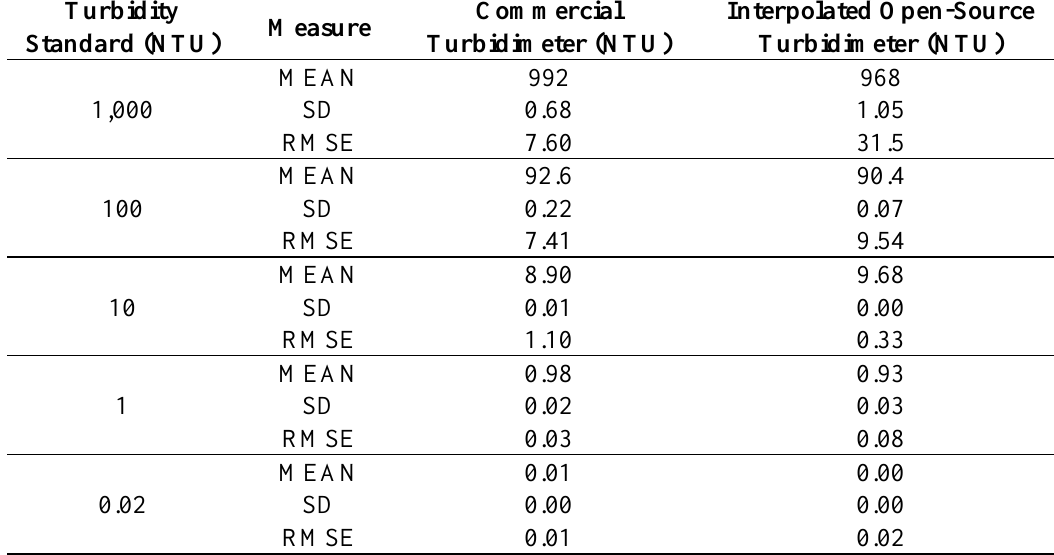
Table 1. Mean, standard deviation (SD), and root-mean-square error (RMSE) of commercial and open-source turbidimeter readings of five non-formazin turbidity